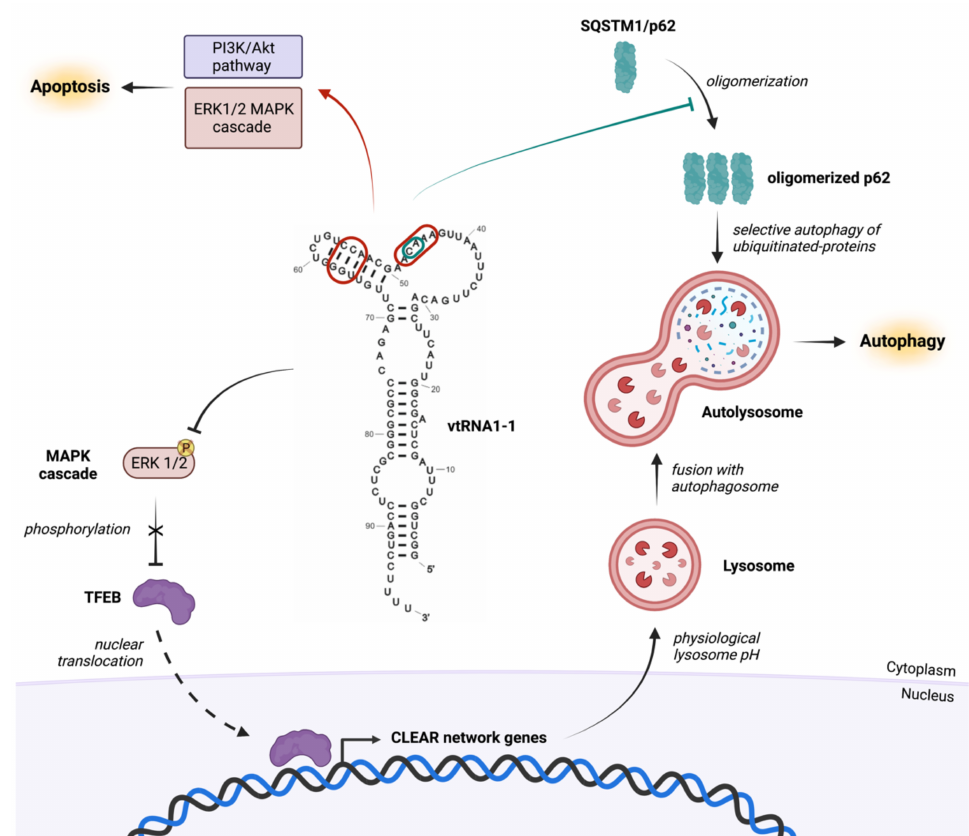
Figure 3. vtRNA1-1 regulates apoptosis and autophagy in cancer cells. In most studied cell lines (HeLa, BL41, BL2, A549, HEK293 and Hs578T), vtRNA1-1 is a pro-survival factor that inhibits apoptosis most likely through the regulation of the PI3K/Akt and ERK1/2 MAPK signaling pathways (red arrow). The important nucleotides in the central domain of vtRNA1-1 for apoptosis resistance are encircled in red [48,50]. In variance, in hepatocellular carcinoma cells (Huh-7), vtRNA1-1 does not affect apoptosis but positively regulates autophagy via the MAPK/TFEB signaling pathway that modulates the expression of the CLEAR network genes (black T-bars and arrows). This ensures